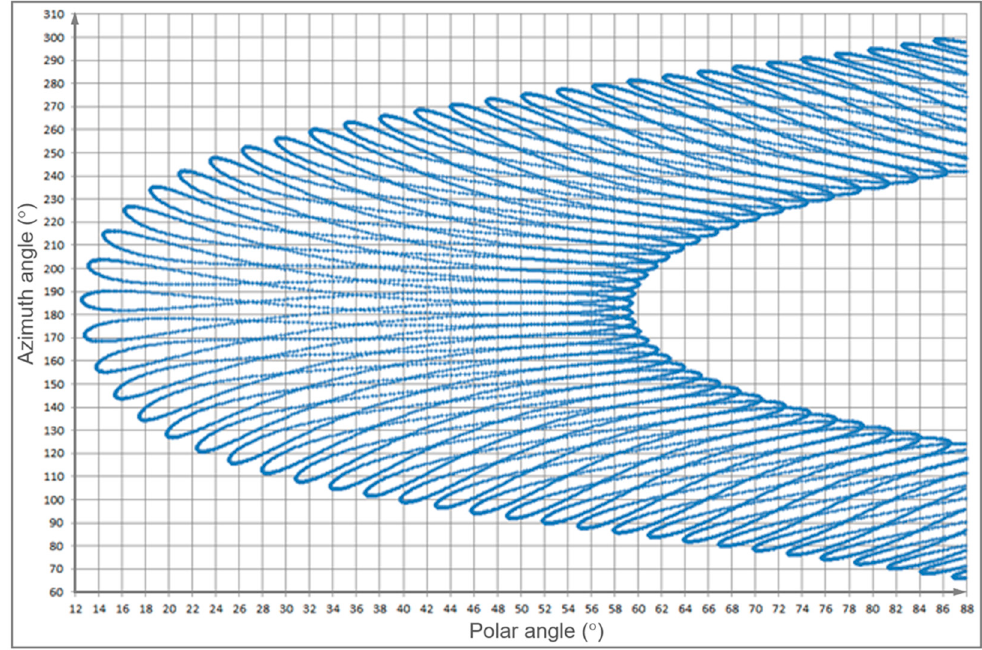
Figure 2. Sun position in the hemisphere during a year; azimuth is vertical and polar angle is hor- izontal. is